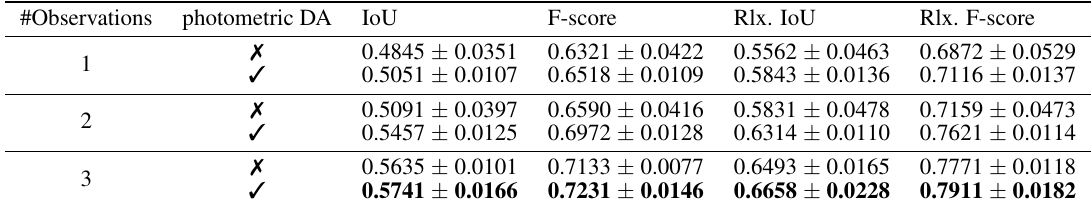
Table 3. Results obtained in test set for the building extraction task.